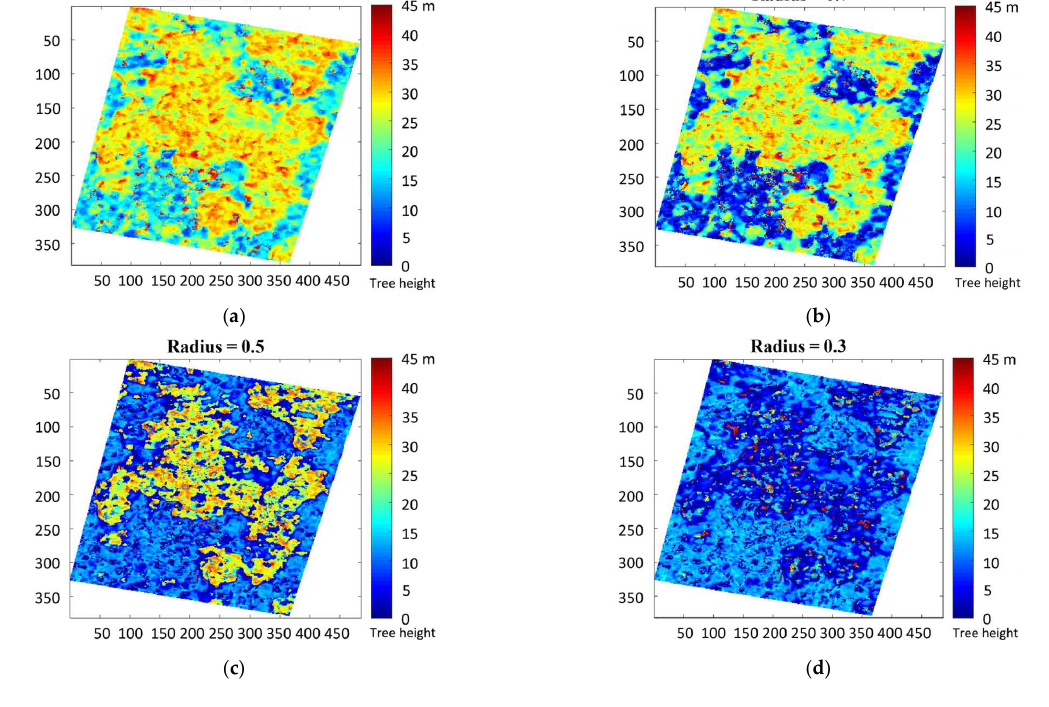
Figure 6. Forest height maps derived from DF-RMoG with different compensation factor values (temporal baseline of 46 days). (x, y: the column and the row of the inversed forest height maps). ( a ) Compensation factor value: 0.9, ( b ) Compensation factor value: 0.7, ( c ) Compensation factor value: 0.5, ( d ) Compensation factor value: 0.3.